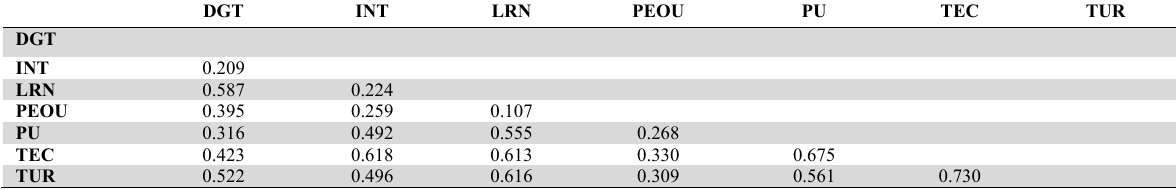
Heterotrait-Monotrait Ratio